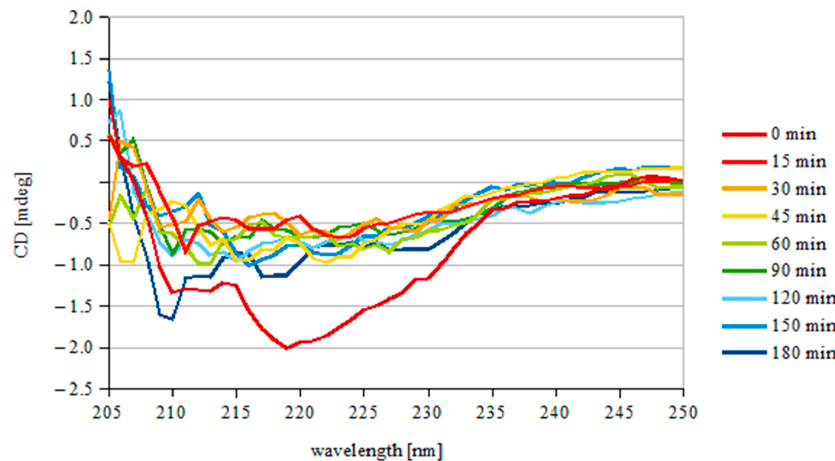
Figure 3. Protein stability under the experimental conditions. Each curve is the mean value of three separate scans. The scFv D2–5-HT1A protein was incubated in MEM + 10% FBS for 15–180 min and then scanned. The values for the medium without scFvD 2 –5-HT1A were subtracted.